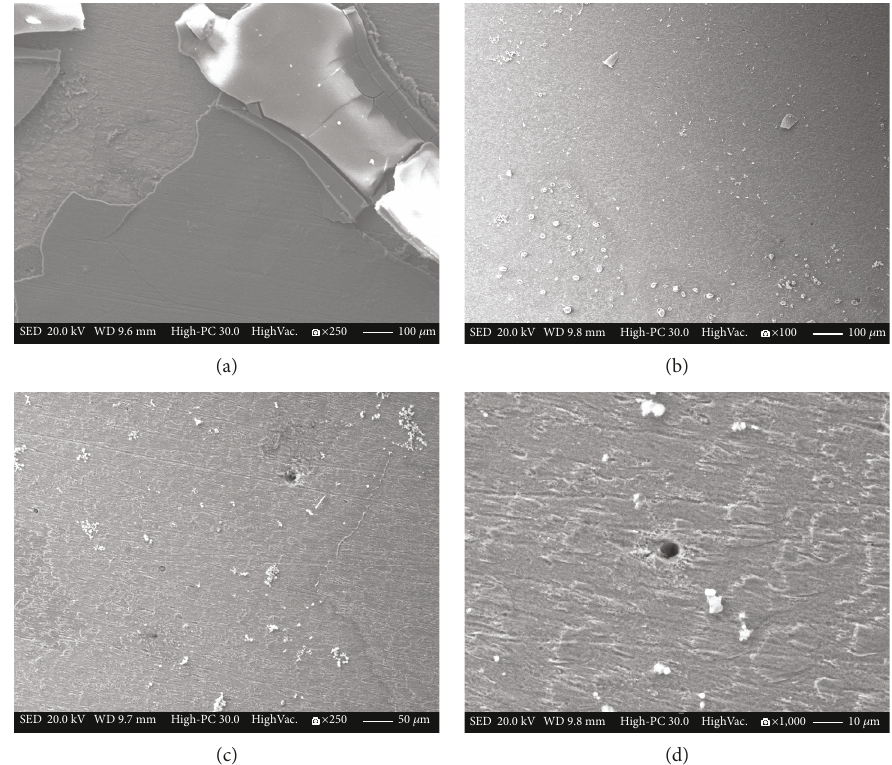
Figure 17: Morphological aspects of carbon steel coated with a chitosan fi lm after 24 hours of immersion in a 3.5% NaCl solution at room